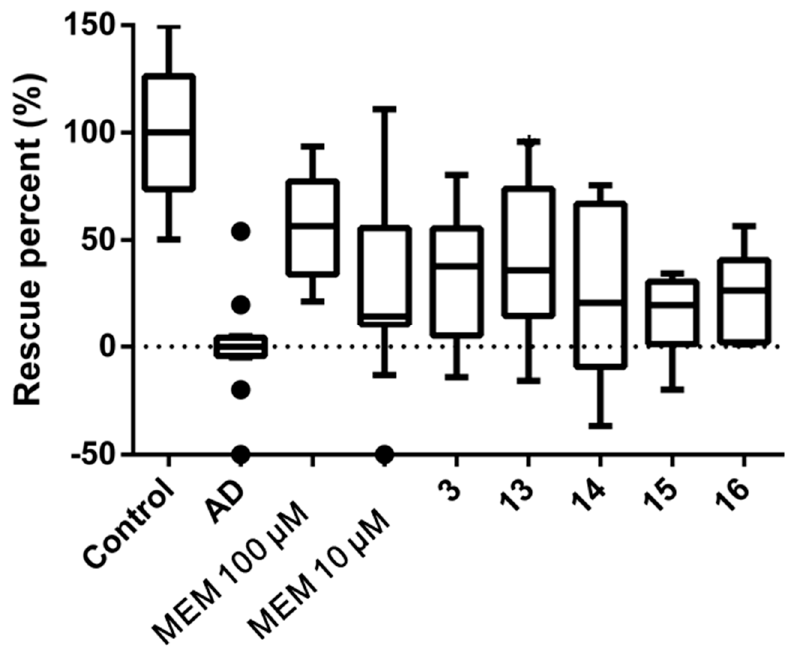
Figure 2. Differential effects of compound 3 and compounds 13 – 16 on rescuing memory deficit on a Drosophila AD model at 10 µ M. The data are shown as means ± SD and analyzed by Tukey’s test; n ≥ 20.